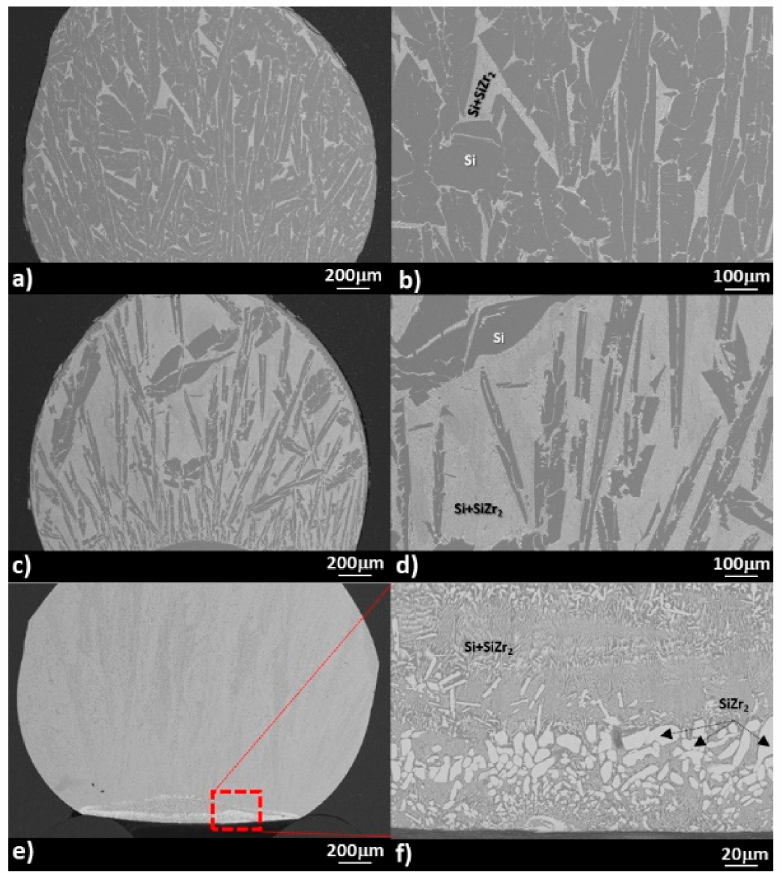
Figure 1. SEM / BSE (back-scattered electron) images and proposed phase identification by EDS analyses that were performed at two magnifications of the cross-sectioned as-produced alloys samples: ( a ) and ( b ) Si-5Zr; ( c ) and ( d ) Si-15Zr; and ( e ) and ( f ) Si-27Zr. As can be seen, a two-phase of Si + SiZr 2 that was segregated at the Si-grain boundaries was detected both in the bulk of Si-1.7 at.% Zr and Si-5.3 at.% Zr alloy samples (i.e., Si-5 wt.% Zr and Si-15 wt.% Zr, hereafter denoted as Si-5Zr and Si-15Zr). The predominance of the Si + SiZr 2 phase depended on the Si content, as